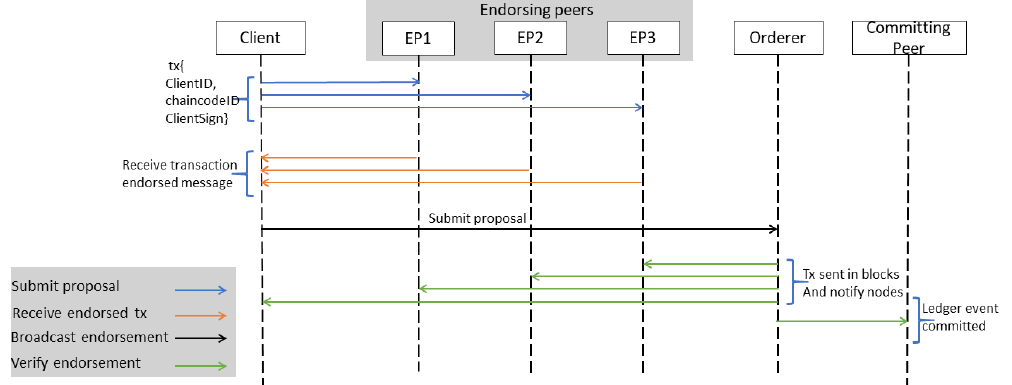
Figure 5. Sequence diagram for transaction flow.